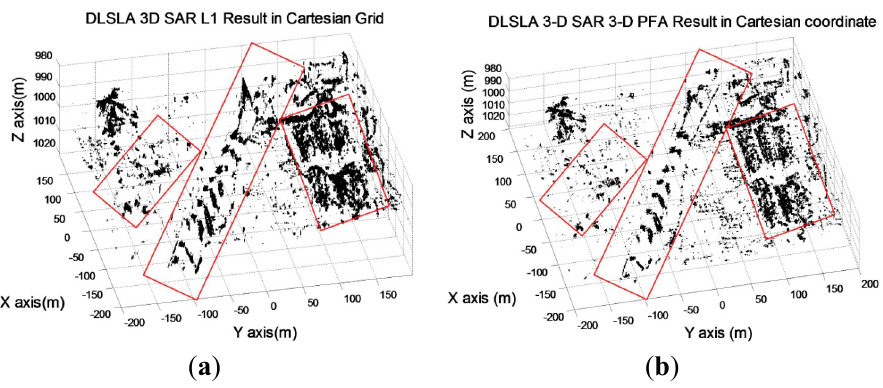
Figure 19. 3-D image: ( a ) 3-D image reconstructed with polar formatting and L1 regularization. ( b ) 3-D image reconstructed with 3-D PFA.